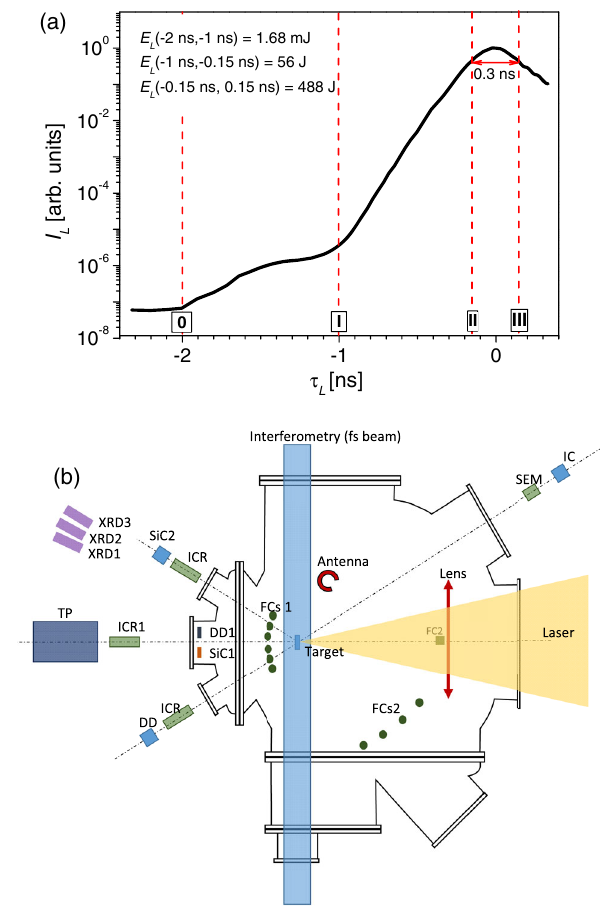
FIG. 2. (a) PALS laser temporal profile: intensity ( I L ) in arbitrary units (the laser-energy E L content in different time windows is reported in the caption) versus time ( τ L ). (b) Sketch of the setup used in the experiment with the H target (top